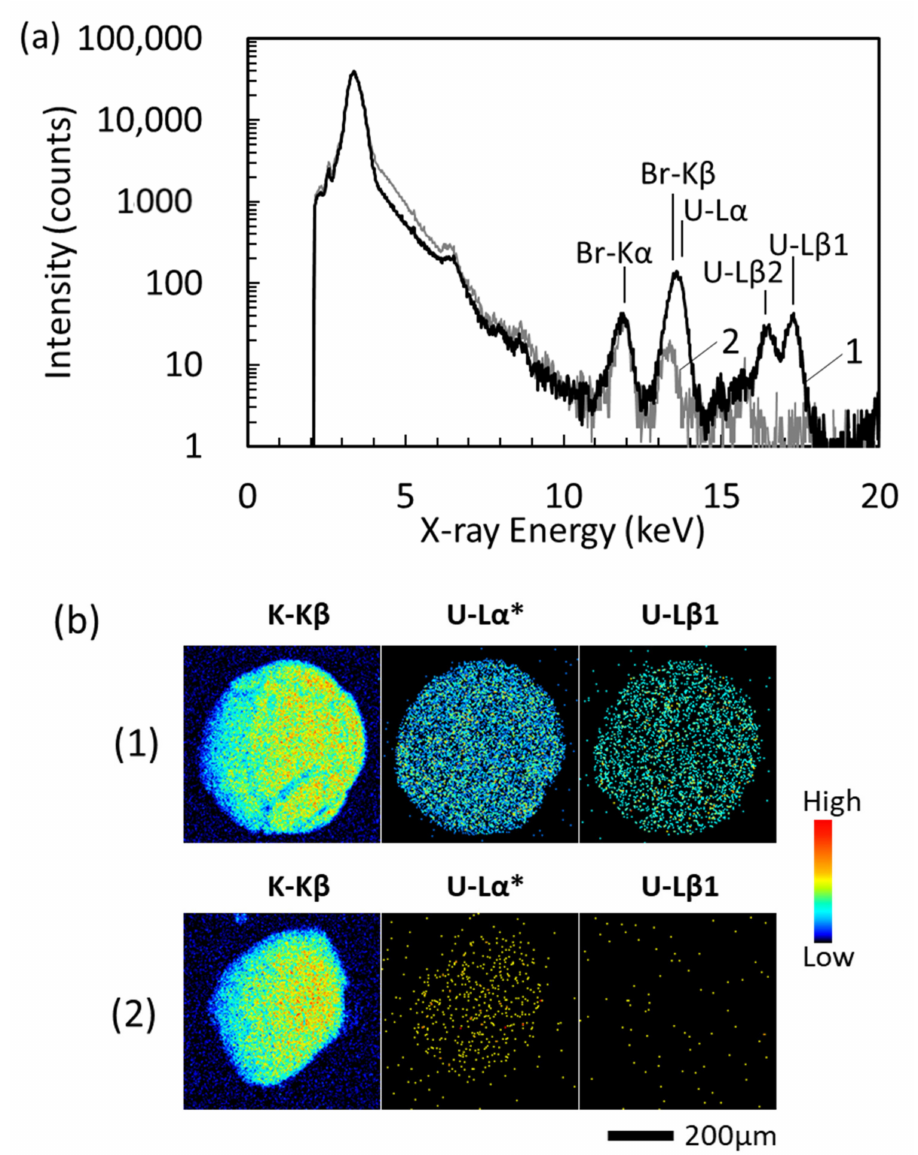
Figure 3. ( a ) µ -PIXE spectra of specimens prepared using 1 µ L droplet of mixed solutions of urine treated with five- foldHNO 3 containing 50 µ g/g U for curve 1 and that without U for curve 2. ( b ) X-ray imaging of K-K β by Si(Li) detector, U-L α , and U-L β 1 lines by CdTe detector in the presence (1) and absence (2) of U. *Imaging of U-L α line expresses sum of the counts at U-L α and Br-K β